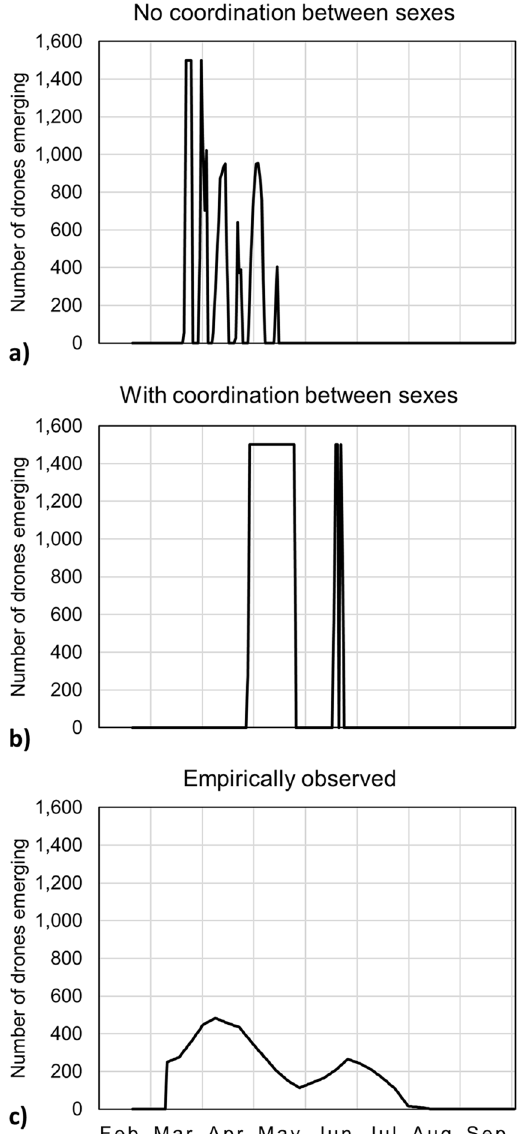
Figure 2. The timing of drone emergence as predicted by the model vs. empirically observed. ( a ) Under model scenario 1, we assume that all other colonies in the population produce queens at an empirically estimated time 19 . We find the optimal solution is for the parent colony to produce all drones early in the spring between March and May, earlier than empirically observed. ( b ) Under model scenario 2, we assume that all colonies in the population produce queens and swarm on the same days as the focal colony; in other words, all colonies follow the same optimal timing. Under this assumption, the optimal solution is to produce a first pulse of drones from late April to late May and produce a second pulse of drones in June. ( c ) The bottom panel shows the empirically observed number of drones emerging each day 19 . Model scenario 2 predicts that colonies should start producing drones later and stop producing drones earlier than empirically observed but captures the empirically observed pattern of two distinct peaks in drone